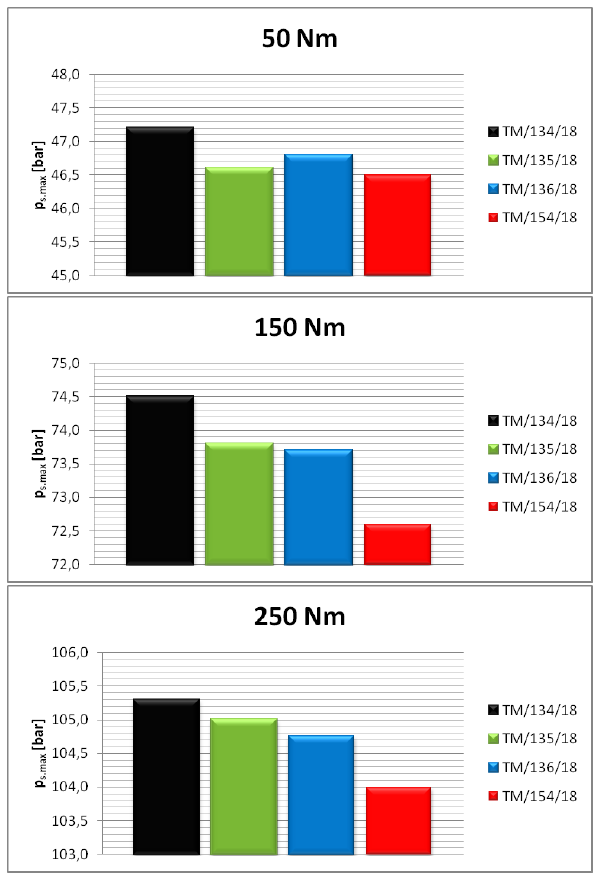
Fig. 4. Changes in the pressure in the engine cylinder as a function of the crank angle for 2 fuels: low LC value (red line), high LC value (blue line)